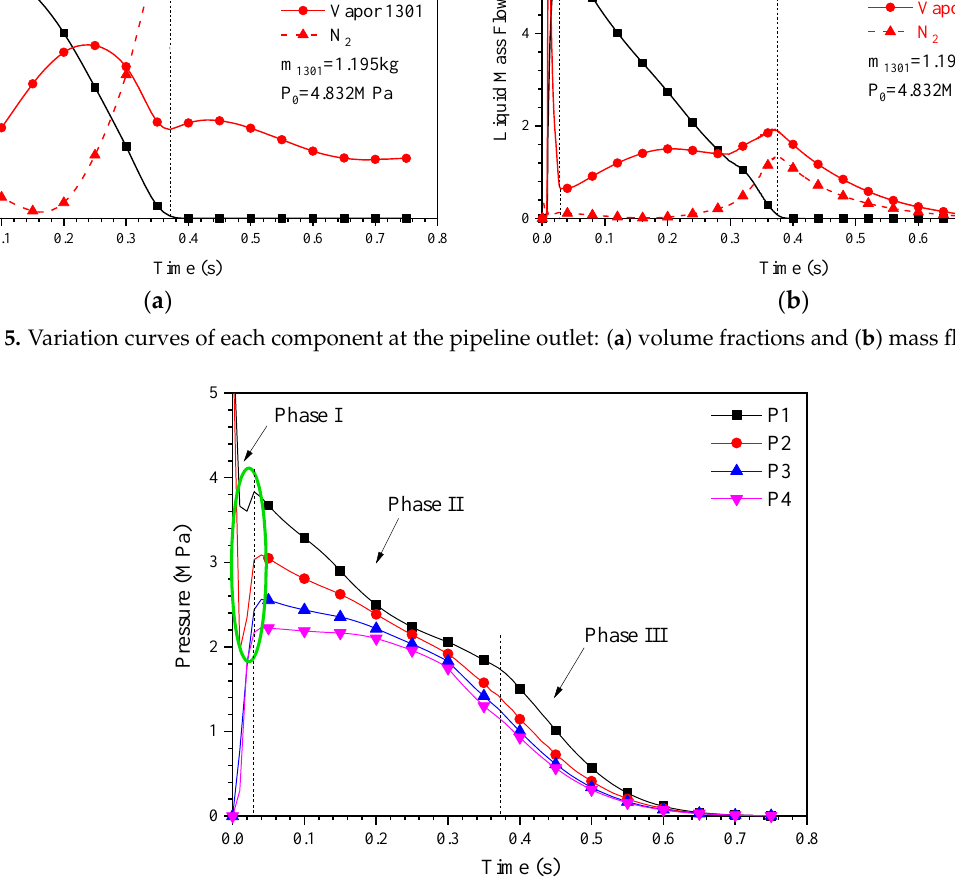
Figure 7. Volume fraction distribution of the liquid 1301 agent at different moments.